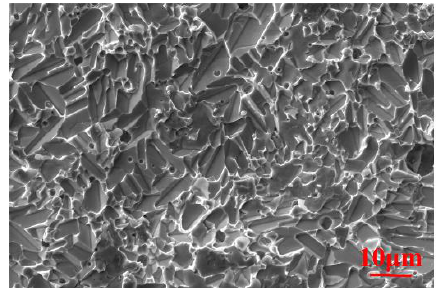
Figure 5. The surface morphology of BGA under SEM shows the brittle fracture.